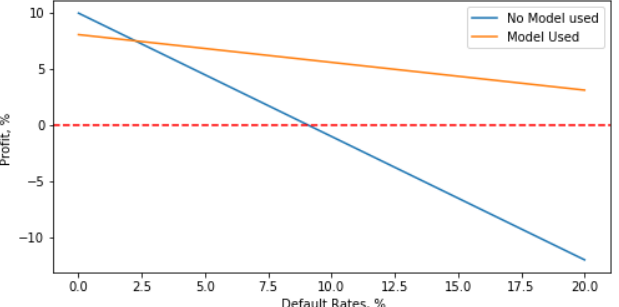
Figure 1. Profit generated by a company charging 10% interest on each loan for a range of default